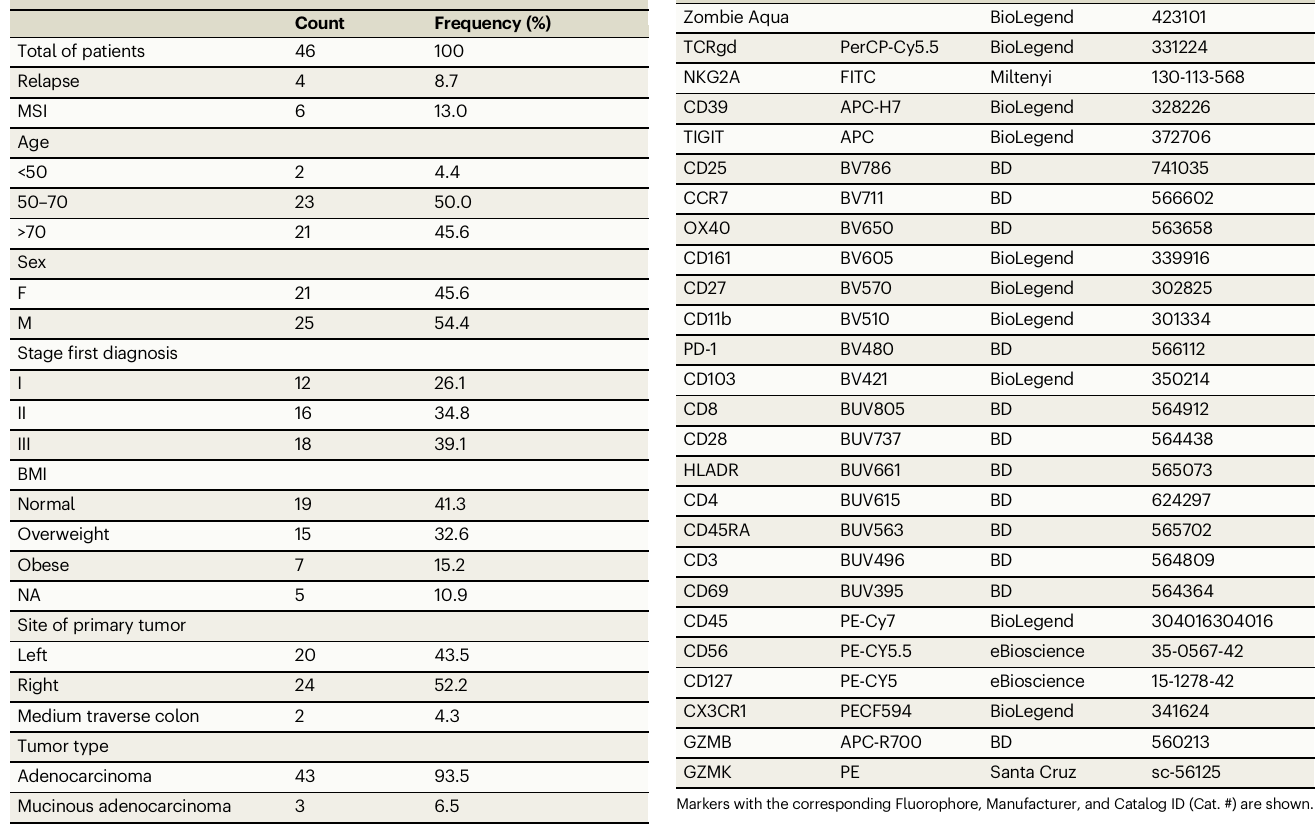
Table 1 | CRC patients ’ characteristics Study Cohort